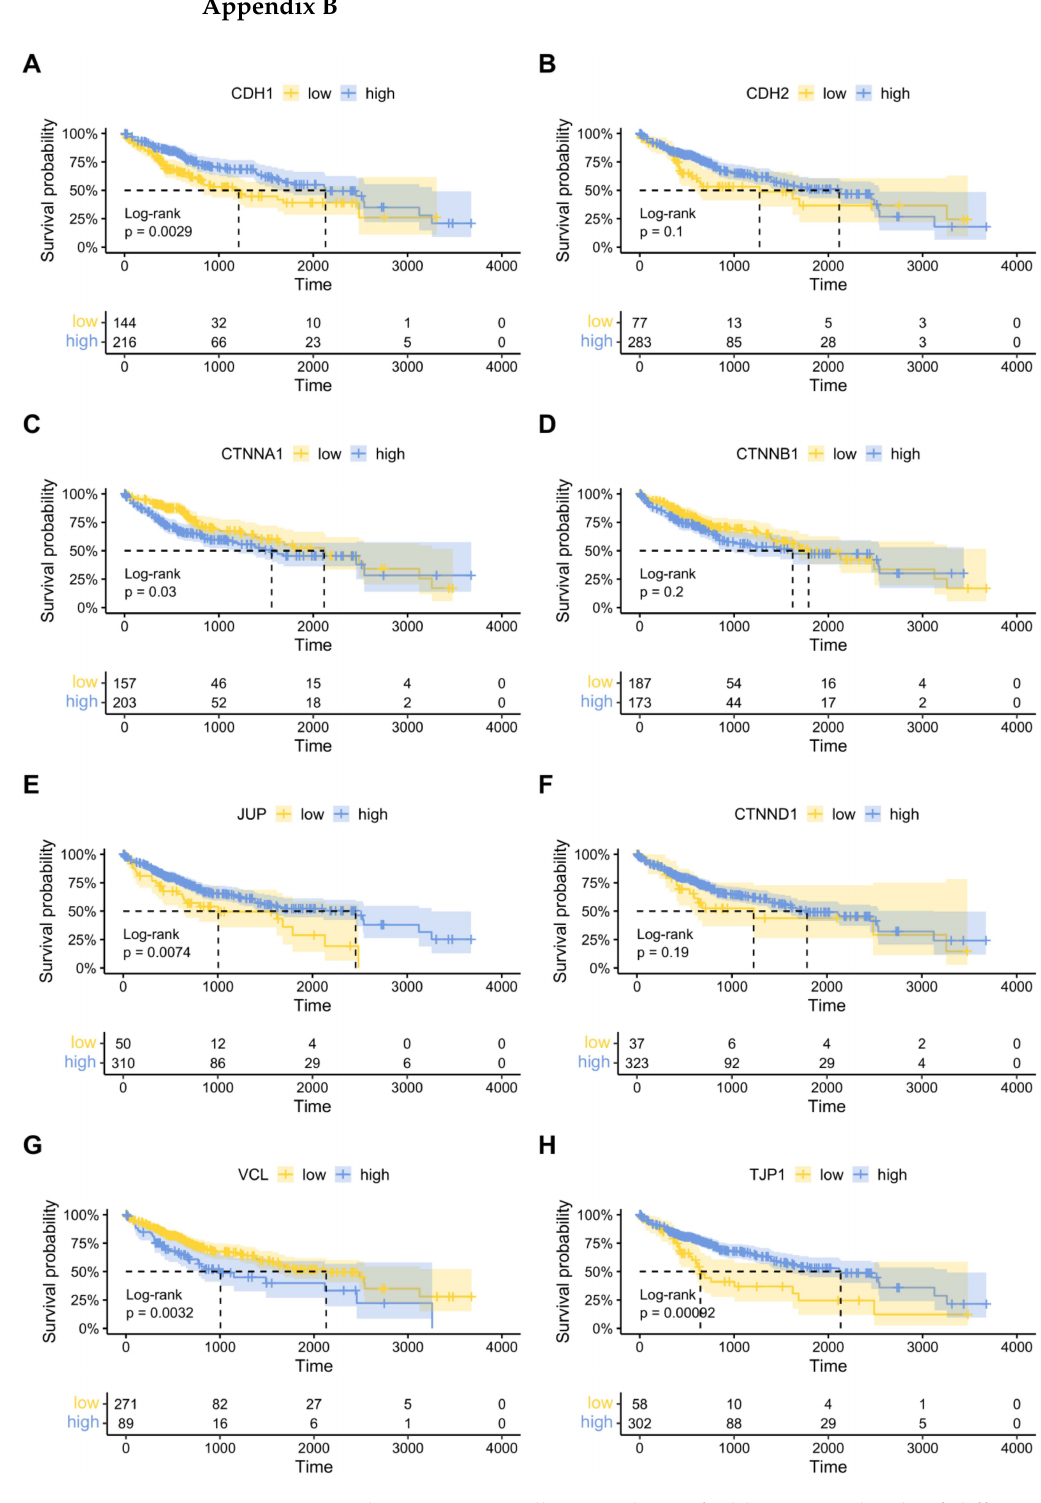
Figure A3. Kaplan–Meier overall survival stratified by mRNA levels of different junction com- ponents in the independent TCGA cohort. Stratification according to mRNA levels of CDH1 ( A , E-cadherin), CDH2 ( B , N-cadherin), CTNNA1 ( C , α -Catenin), CTNNB1 ( D , β -Catenin), JUP ( E , junction plakoglobin), CTNND1 ( F , p120), and VCL ( G , vinculin) of adherens junctions, as well as of TJP1 ( H , zonula occludens-1) of tight